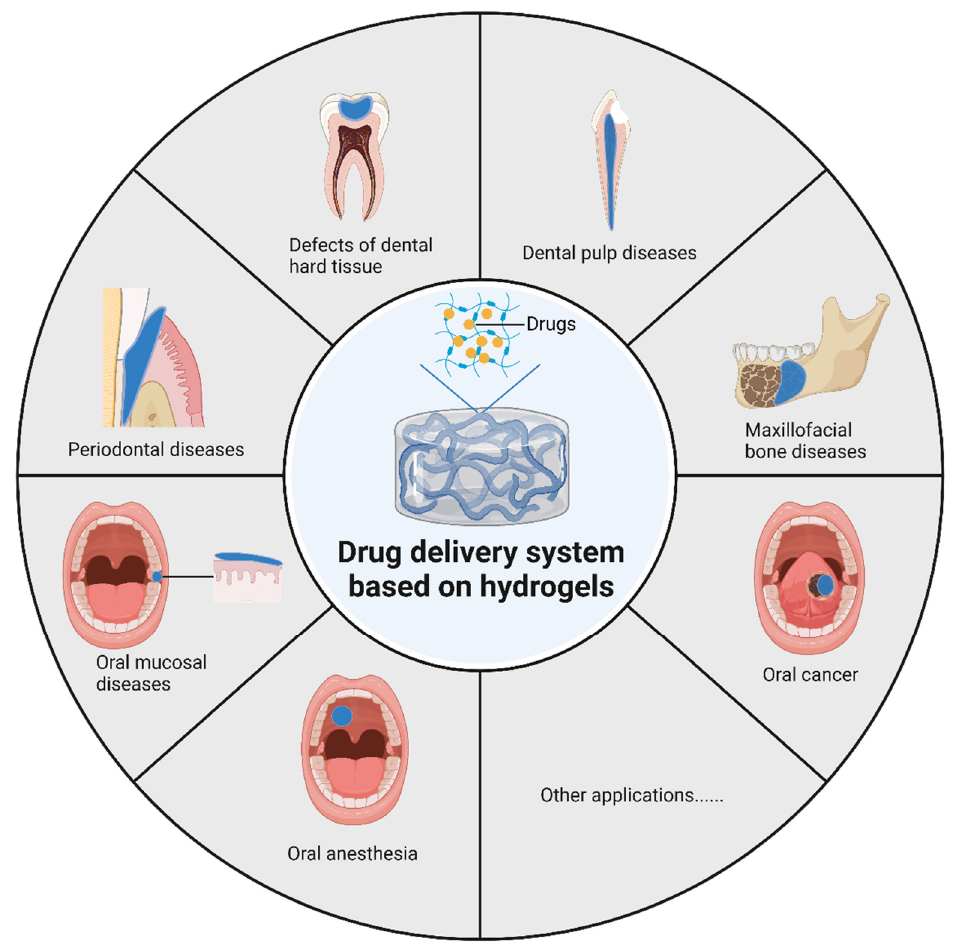
Figure 2. Applications of hydrogels in drug delivery for oral and maxillofacial diseases.